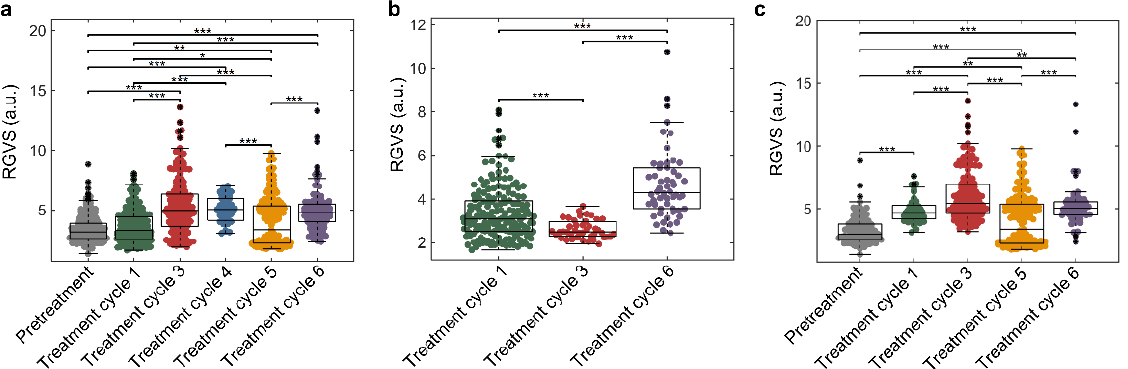
Figure 5. Clinical correlation between patient-derived cell cluster parameters and treatment cycle number. ( a ) Boxplot of RGVS against treatment cycle number, based on samples (Table 1; no. 6–22, 27–31; n = 22) obtained at pretreatment (3.45 ± 1.15), treatment cycle 1 (3.63 ± 1.31), treatment cycle 3 (5.29 ± 2.27), treatment cycle 4 (5.08 ± 1.02), treatment cycle 5 (4.02 ± 2.02), and treatment cycle 6 (4.97 ± 1.66). ( b ) Boxplots of RGVS against treatment cycle number, based on gastric cancer samples ( n = 8) obtained at pretreatment (3.35 ± 1.21), treatment cycle 1 (2.61 ± 0.42), and treatment cycle 3 (4.67 ± 1.60). ( c ) Boxplots of RGVS against treatment cycle number, based on breast cancer samples ( n = 10) obtained at pretreatment (3.26 ± 1.08), treatment cycle 1 (4.87 ± 1.01), treatment cycle 3 (6.04 ± 2.00), treatment cycle 5 (4.02 ± 2.02), and treatment cycle 6 (5.23 ± 1.68). *** Represents p ≤ 0.001, ** represents p ≤ 0.01, and * represents p ≤ 0.05.